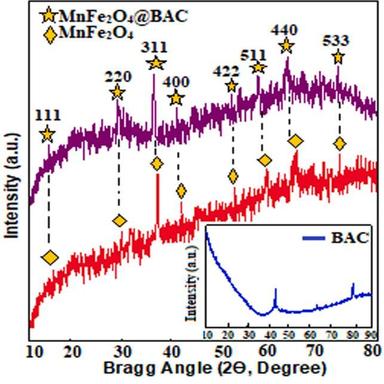
XRD pattern of BAC, MnFe2O4, and MnFe2O4@BAC.